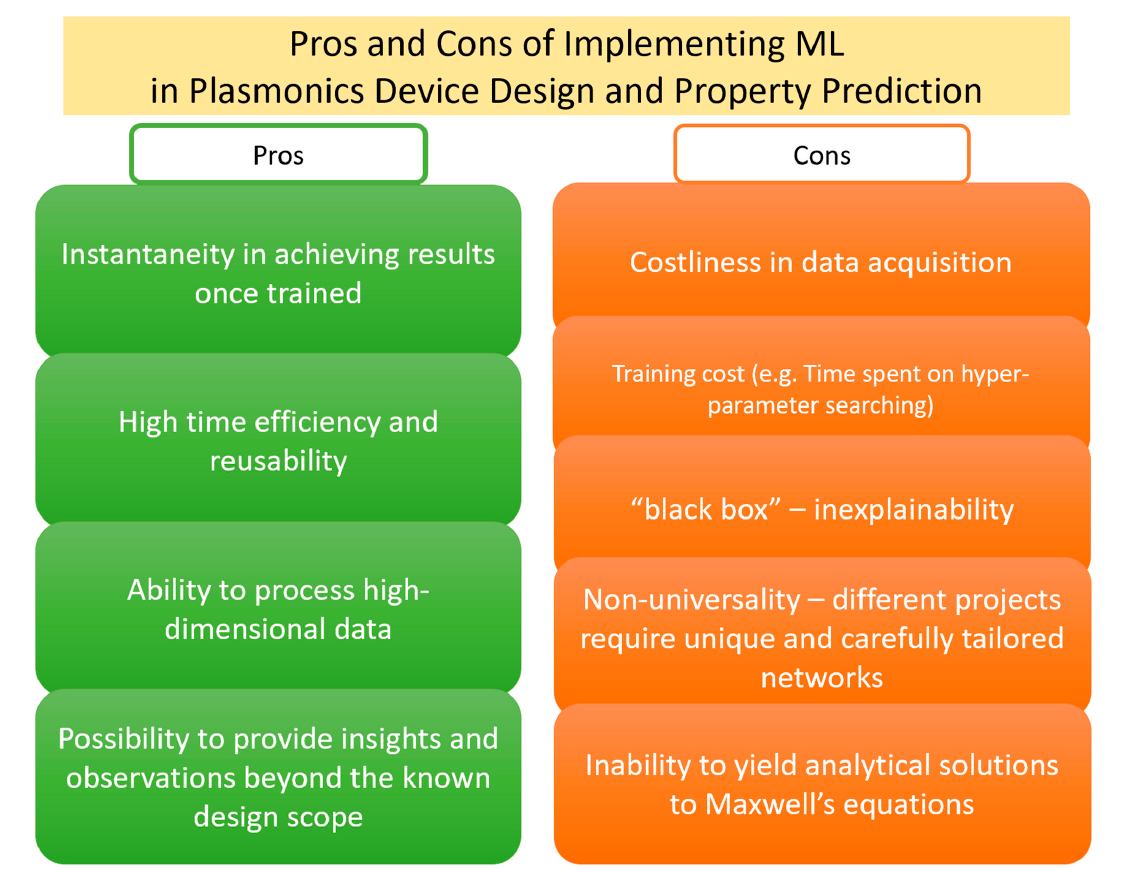
Figure 2. This figure concludes the pros (green) and cons (orange) of ML applications in the field of plasmonic devices. The major advantages include high time efficiency, reusability, robustness